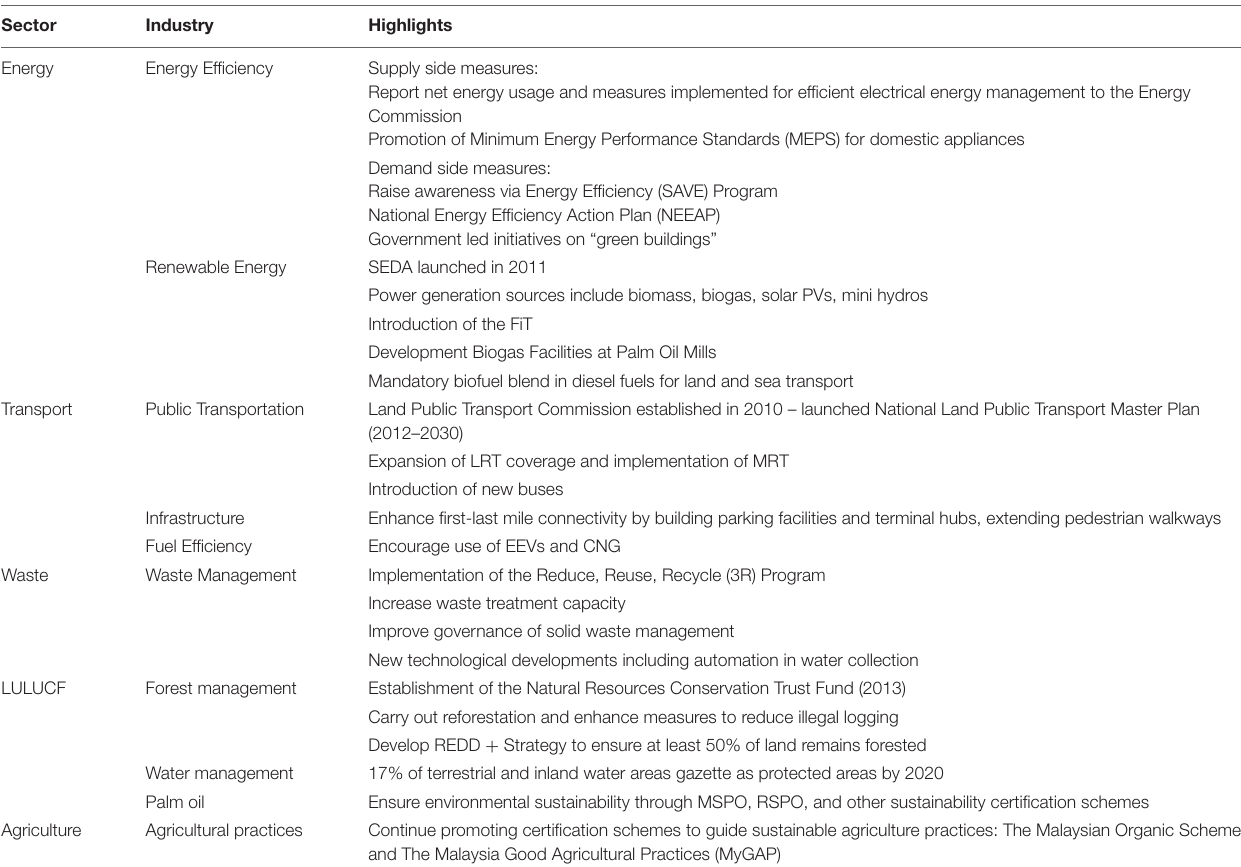
TABLE A1 | Overview of Malaysia’s sector-specific carbon emissions intensity reduction